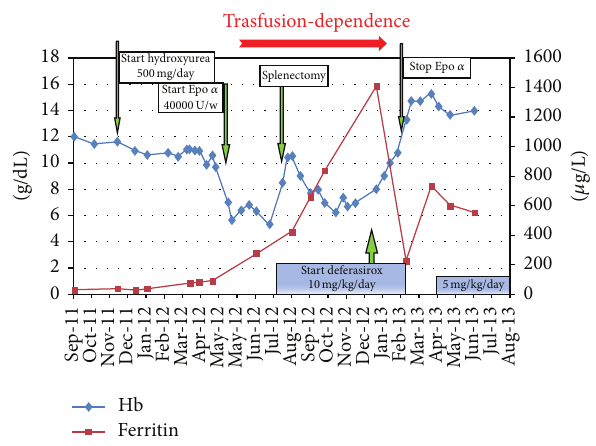
Figure 1: Hemoglobin and ferritin variations during the clinical